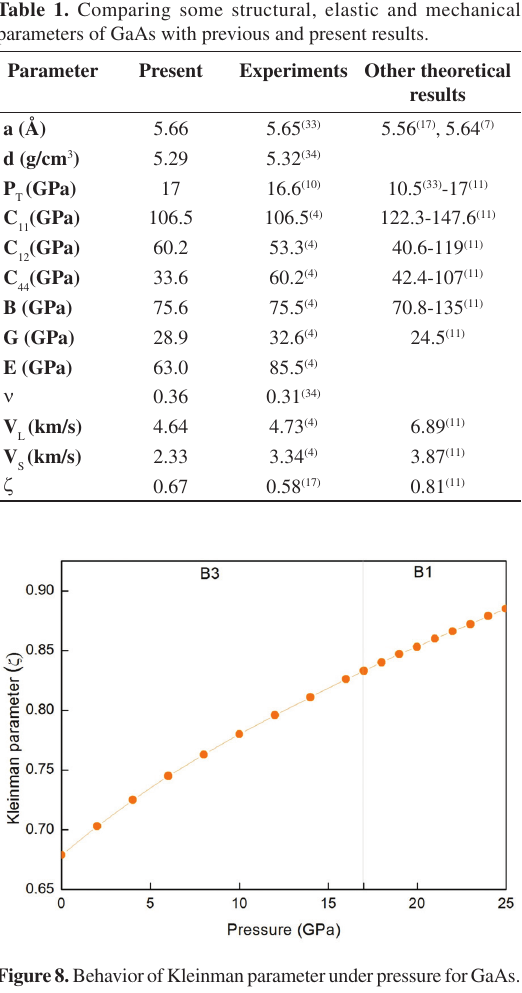
Figure 8. Behavior of Kleinman parameter under pressure for GaAs.